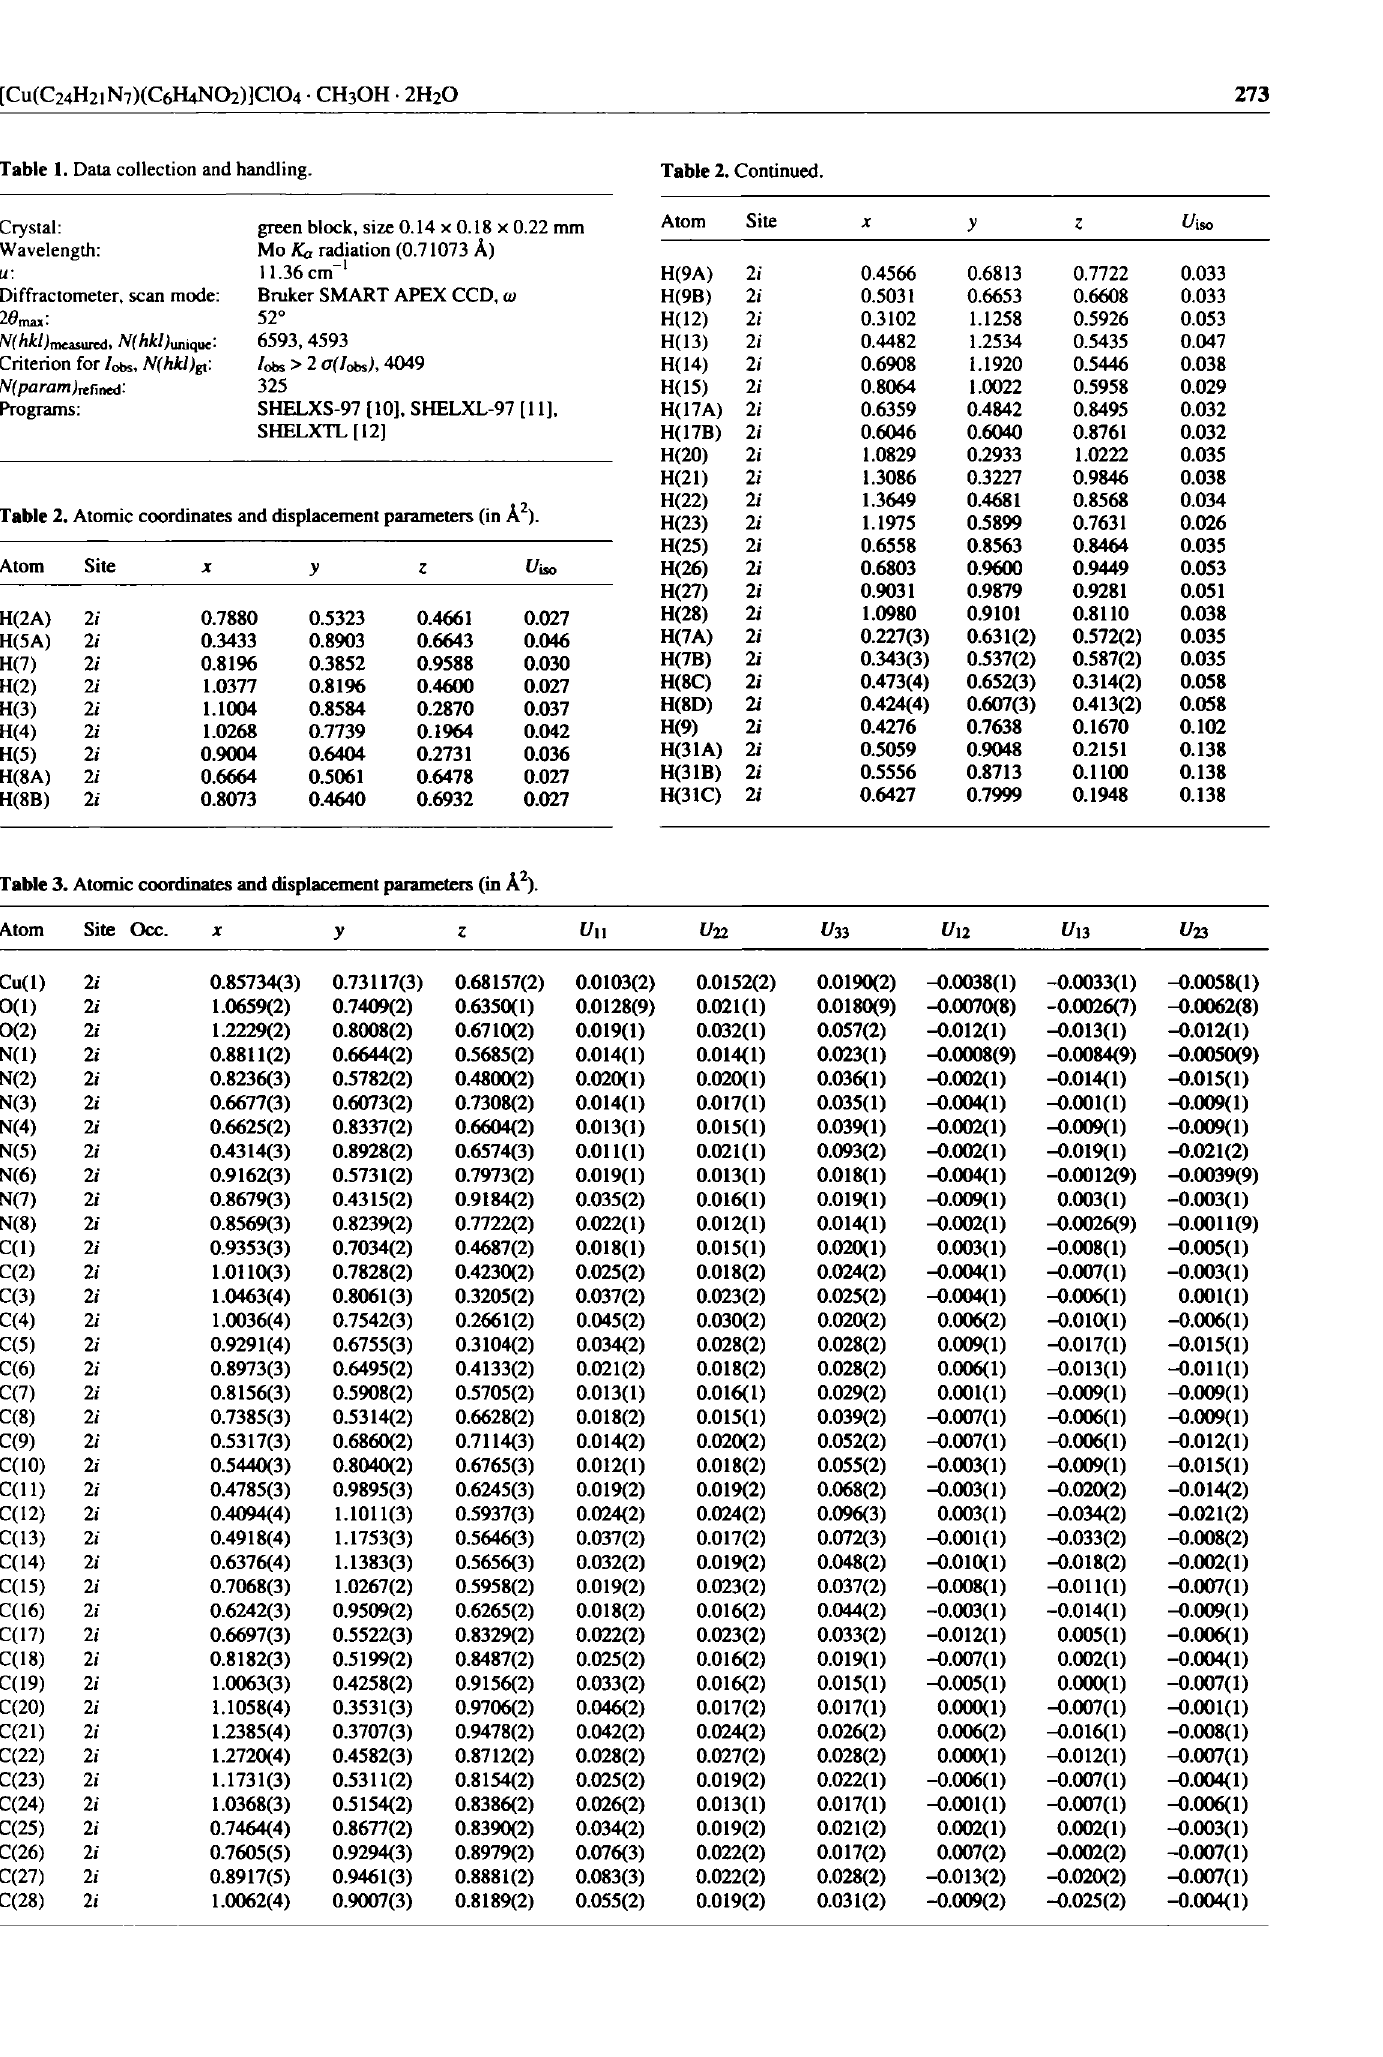
Table 2. Atomic coordinates and displacement parameters (in Â 2 ).